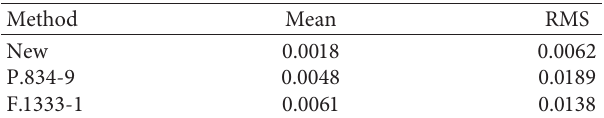
Table 2: Errors for an orbit of 1,000km when the apparent ele- vation angle is known (in degrees).